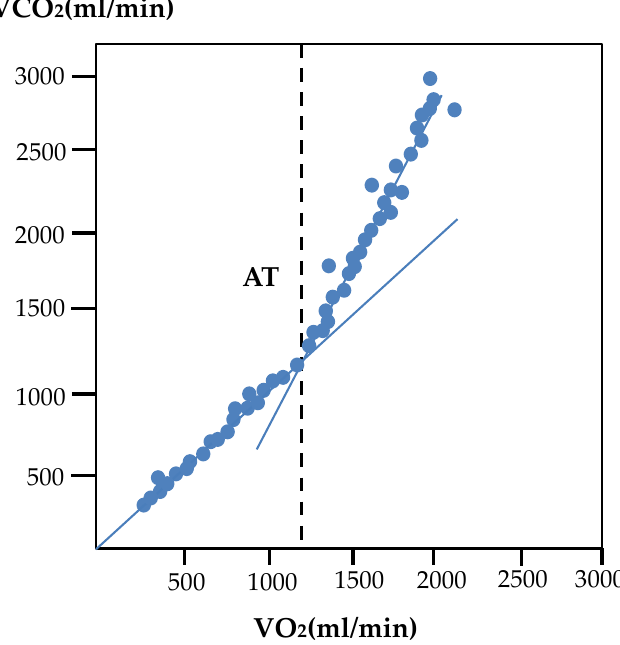
Figure 1. AT using the V-slope method. Eric et al. [14] presented a gas exchange plot from the submaximal exercise test of a representative participant to illustrate identification of the AT. With the V-slope method, the VCO 2 /VO 2 plot is used to identify the point at which the VCO 2 starts to increase more rapidly than VO 2 . The vertical dashed line represents the AT. Figure 1 was created based on subject data.